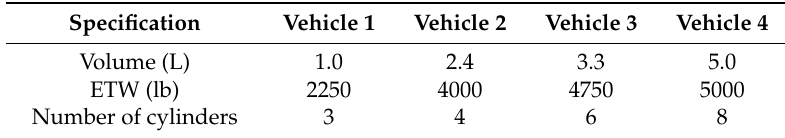
Table 1. Specifications of test